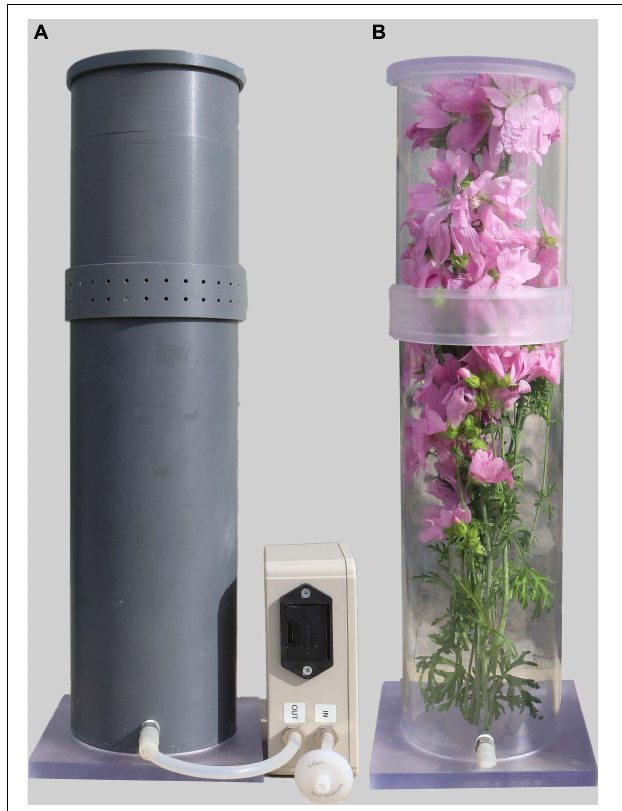
FIGURE 2 | Cylinders to test behavioral responses to decoupled floral cues. The set-up for testing olfactory cues (A) consisted of a gray plastic cylinder that was connected to a pump and that had small holes allowing scent diffusion. For visual cues (B) , transparent plexiglass cylinders were used but without